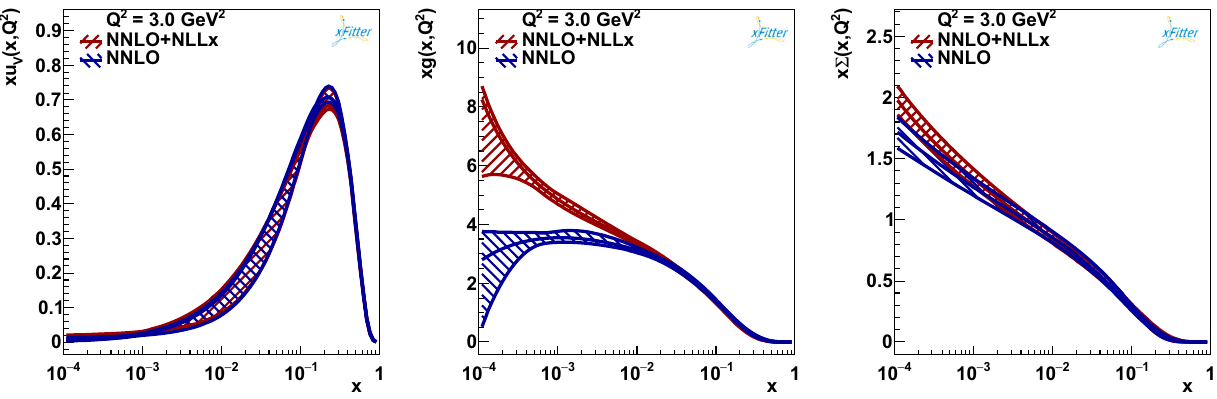
Fig. 3 The up valence PDF xu v , the gluon PDF xg and the total singlet PDF x Σ for the final fits with (NNLO+NLL x ) and without (NNLO) ln ( 1 / x )